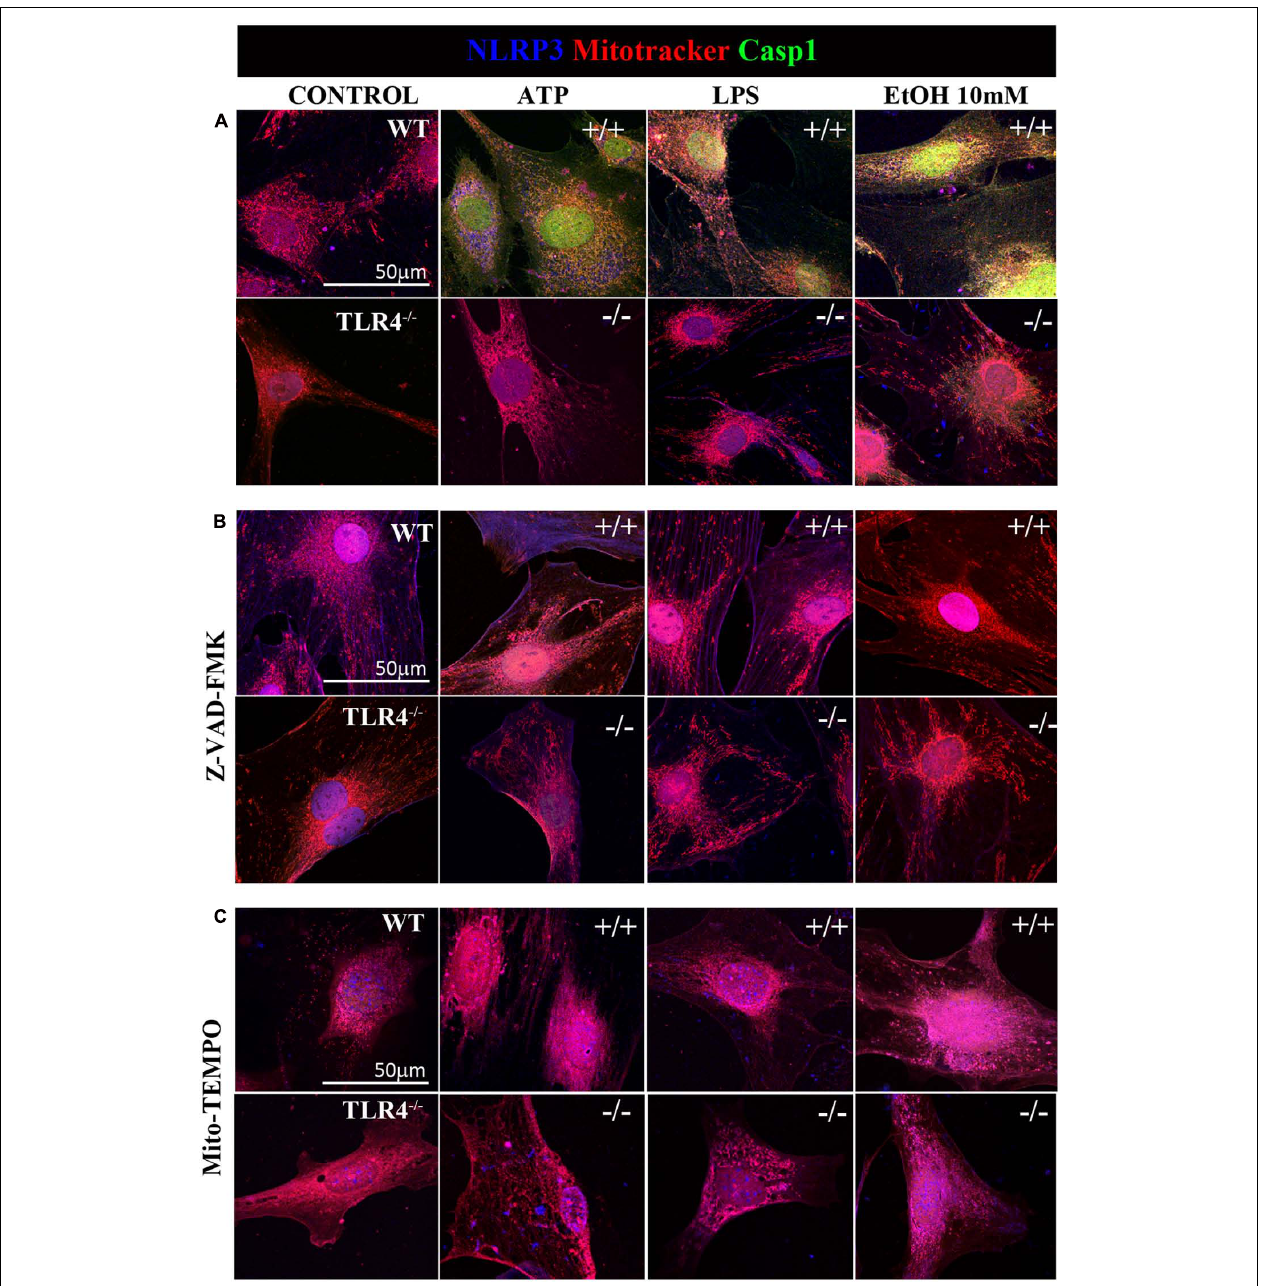
FIGURE 6 | Confocal images of NLRP3/caspase-1 co-localization within mitochondria of the astrocytes treated with ethanol,ATP, or LPS. Microphotographs show that the ATP, LPS, or ethanol (10 mM) treatments promote the co-localization of NLRP3 inflammasome (blue) with active caspase-1 (green) within mitochondria (red) in theWT-astrocytes when